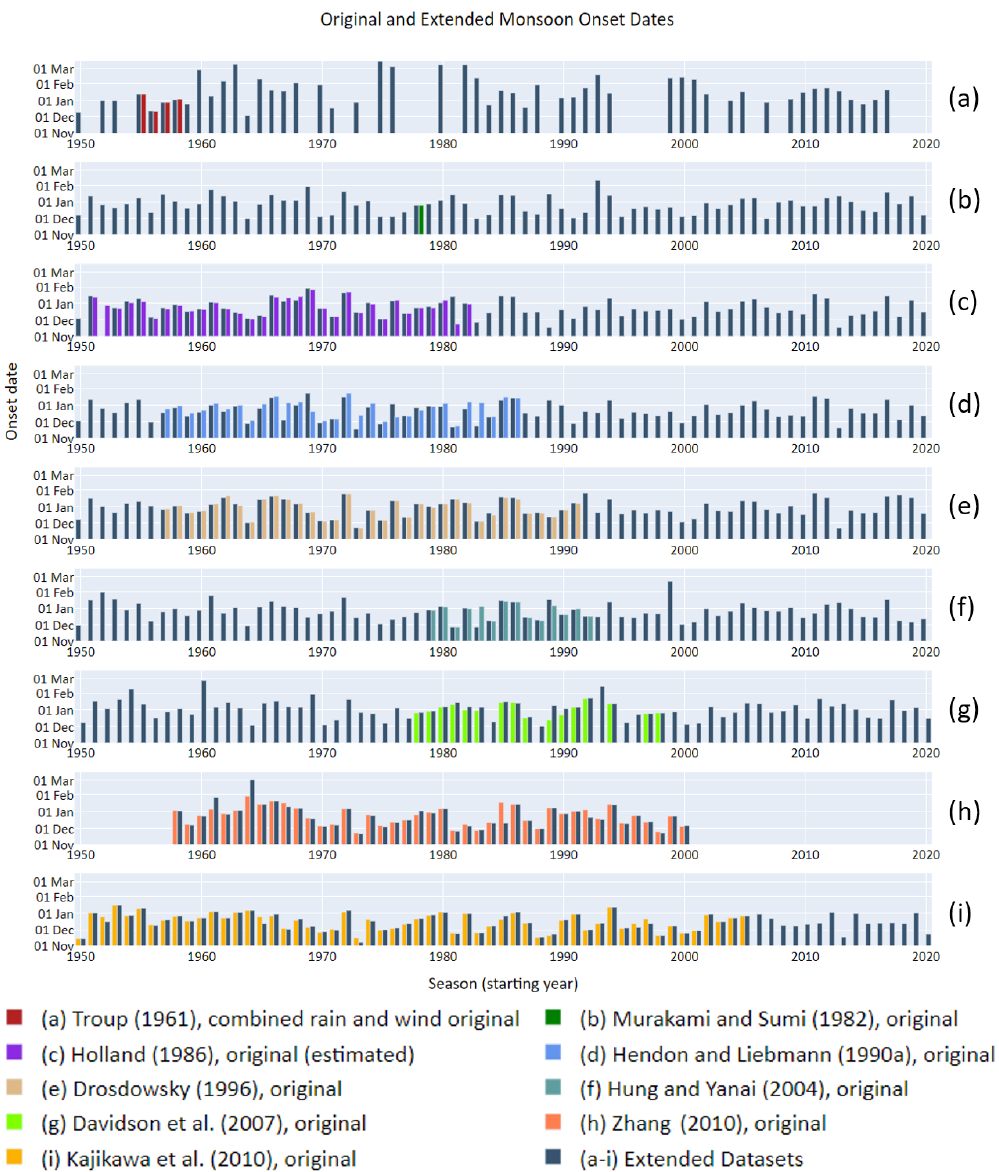
Figure 1. Recreated and extended monsoon onset dates using the methods described in each respective paper.